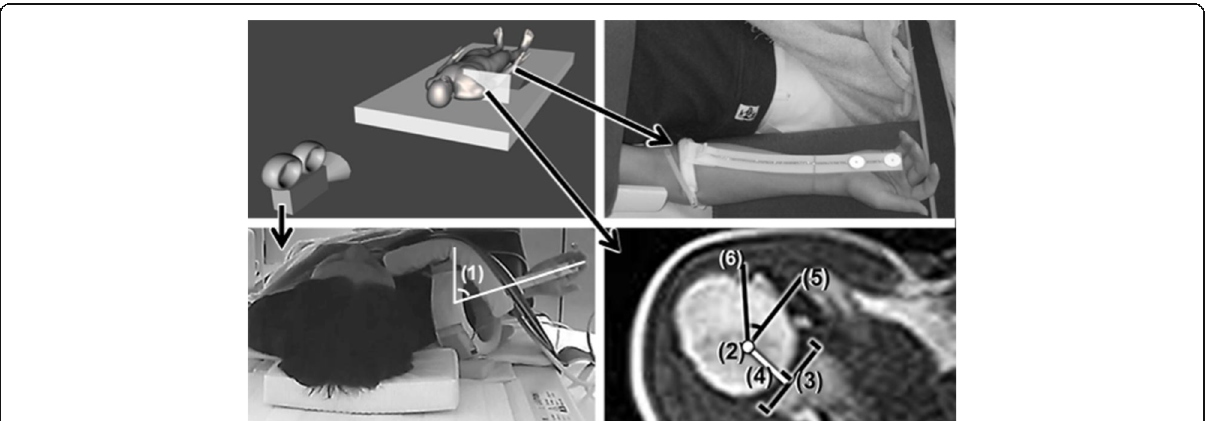
Fig. 1 Experimental imaging. Fig. 1a (left top) shows the view of the video camera that was synchronized with the MRI. Fig. 1b (right top) shows a non-constraining brace applied to the subject ’ s forearm. The position of the brace was not affected by pronation or supination of the forearm. Fig. 1c (left bottom) is a frame captured by the video camera, showing (1) the shoulder rotation angle. Fig. 1d (right bottom), taken from an MRI scan, shows how translation of the humeral head and rotation angle on MRI are defined. (2) Center of the humeral head. (3) Center of the glenoid fossa. (4) Line from the center of the humeral head perpendicular to the glenoid. Translation of the humeral head is defined as the distance between (3) and (4). (5) Line parallel to a line connecting the anterior and posterior edges of the glenoid and crossing the center of the humeral head. (6) Line connecting the bicipital groove to the center of the humeral head. The rotation angle of the humeral head is defined as the angle between (5) and